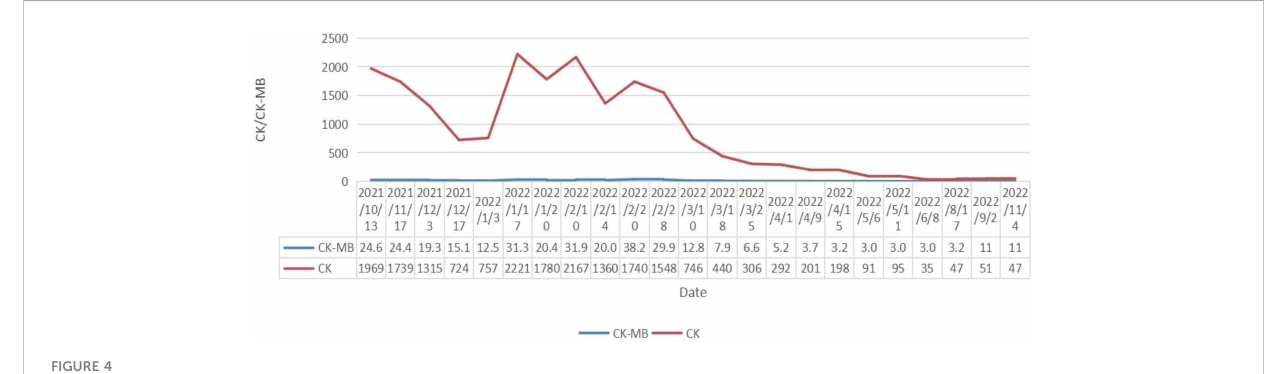
FIGURE 4 Changes of CK and CK-MB throughout the process of the